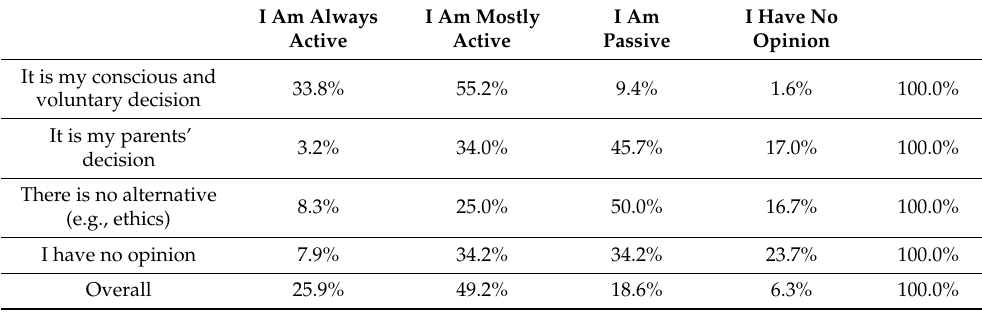
Table 1. Motivations for participation in religious education and commitment during